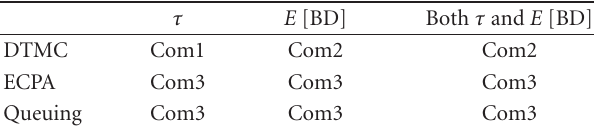
Table 3: Big- O notation for computational complexity of the com- pared